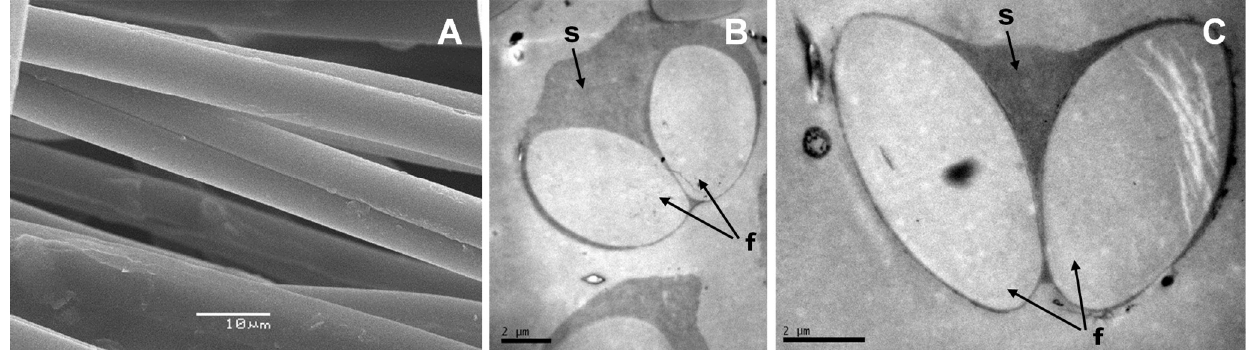
Figure 1. Scanning electron microscopy (SEM) visualization of fibers of raw pine processionary silk ( × 2000) ( A ). The basic unit is formed by 2 fibroin nanofibers arranged in parallel and laterally associated with other fibers of the same nature ( A ); cross sections of silk basic units observed by transmission electron microscopy (TEM) at 6000 magnification ( B ) and 10,000 magnification ( C ). Note the sericin layer (s) acting as a glue that holds the fibroin nanofibers (f) together.